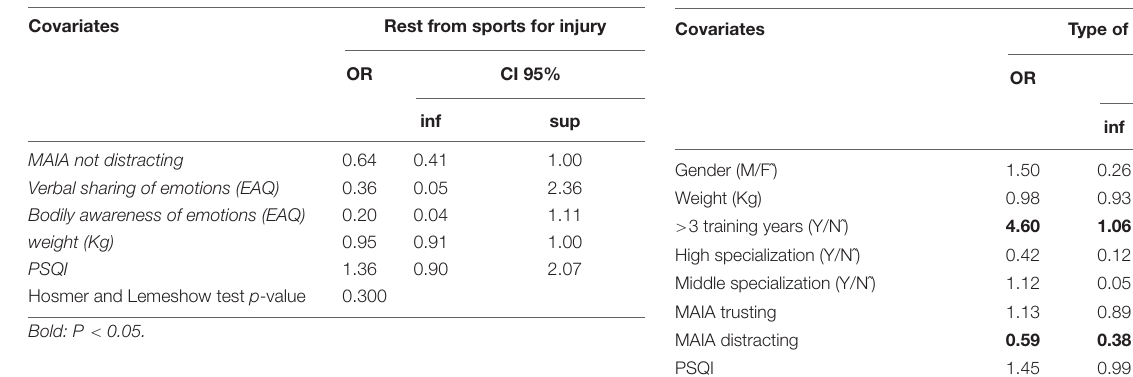
TABLE 3C | Regression model of “Type of injury,